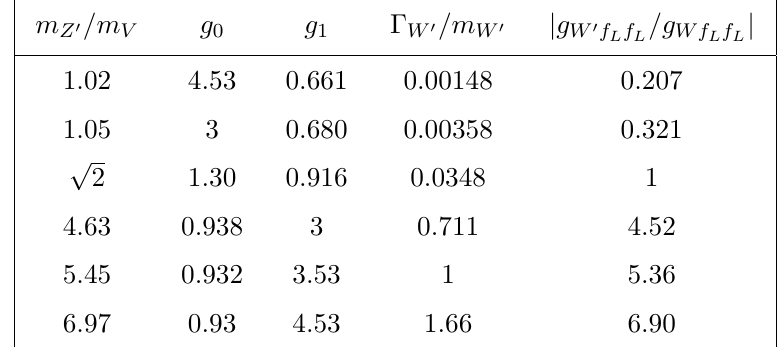
Table 2 . The values of g We show some values of g 0 , g 1 , (cid:0) W 0 =m W 0 , and j g W 0 f